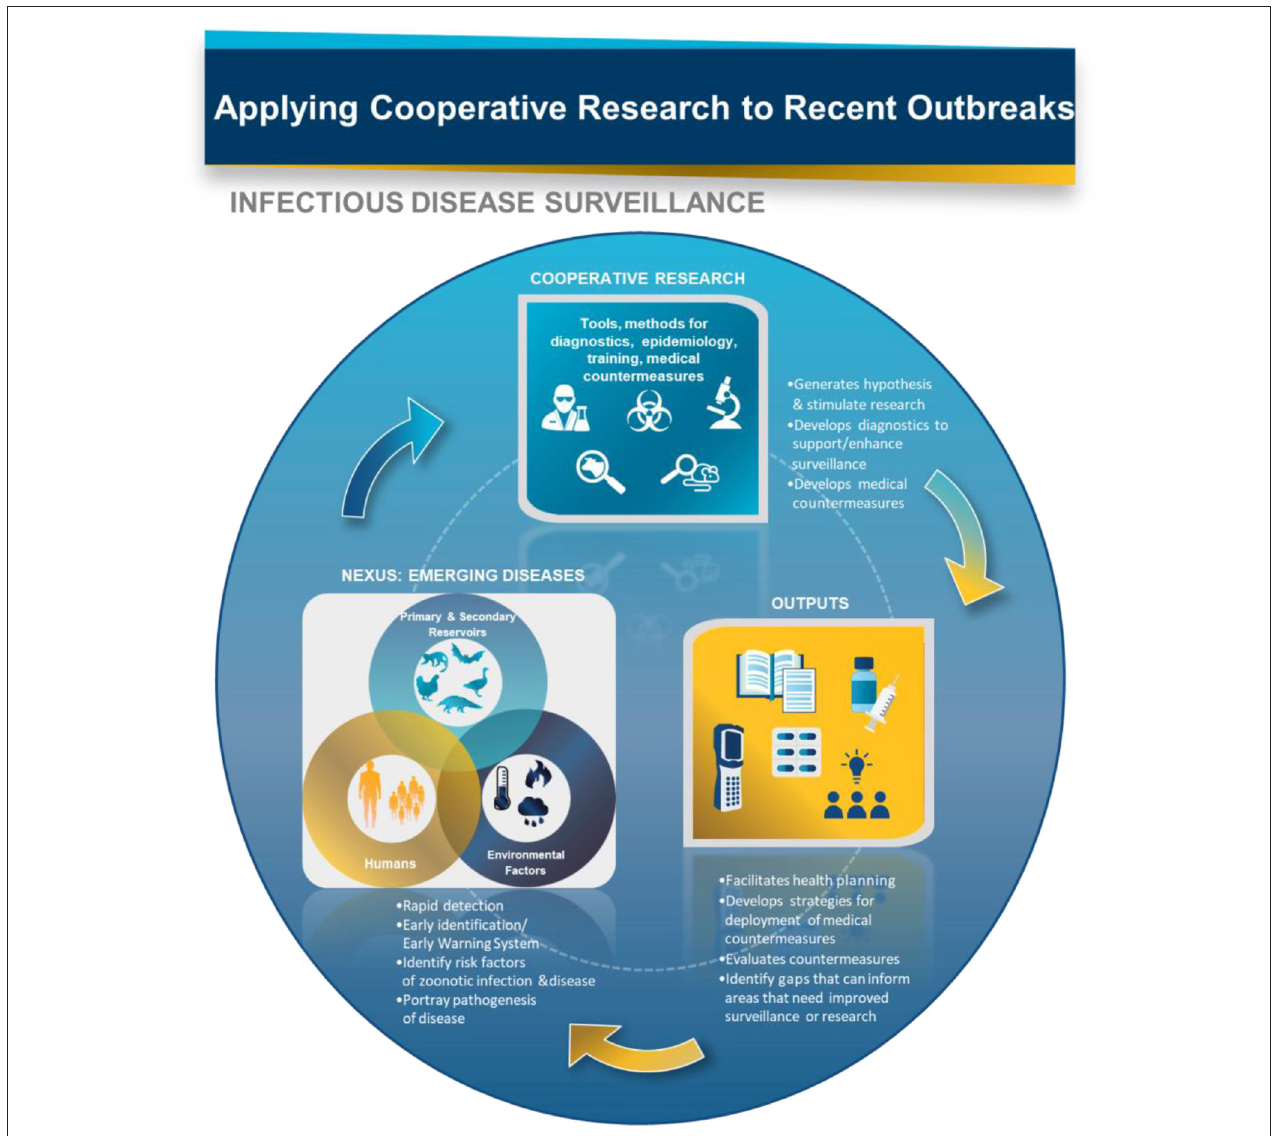
FIGURE 1 | Infectious disease surveillance is a vital component in the response to disease outbreaks and the subsequent development of effective countermeasures. COVID-19 demonstrates the need for faster turnaround to meet technical, logistical, and production